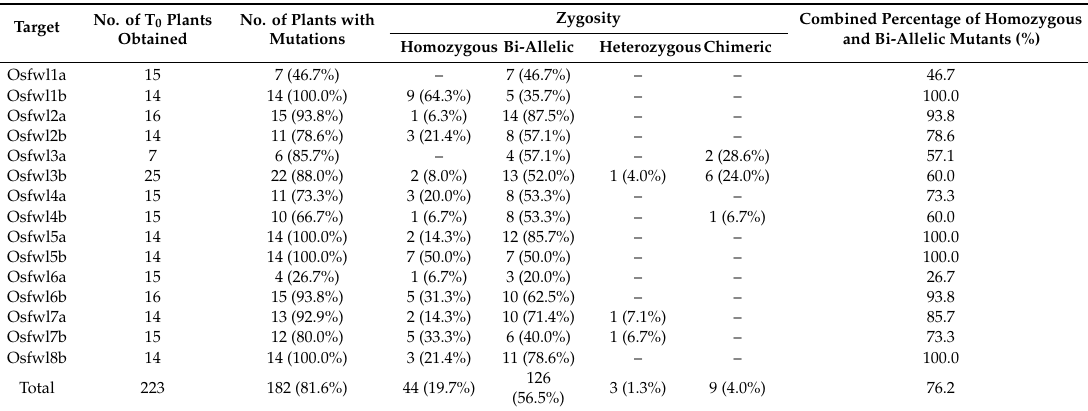
Table 2. Identification of targeted mutations in T 0